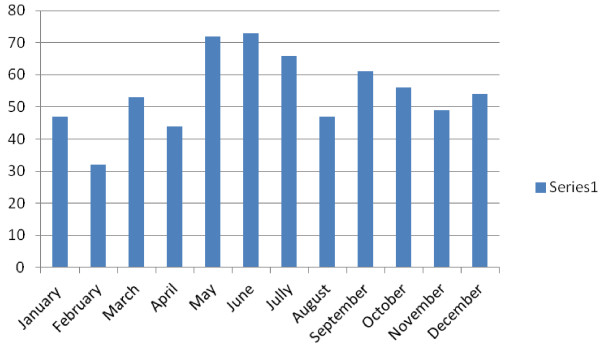
Monthly distribution of occupational accidents.